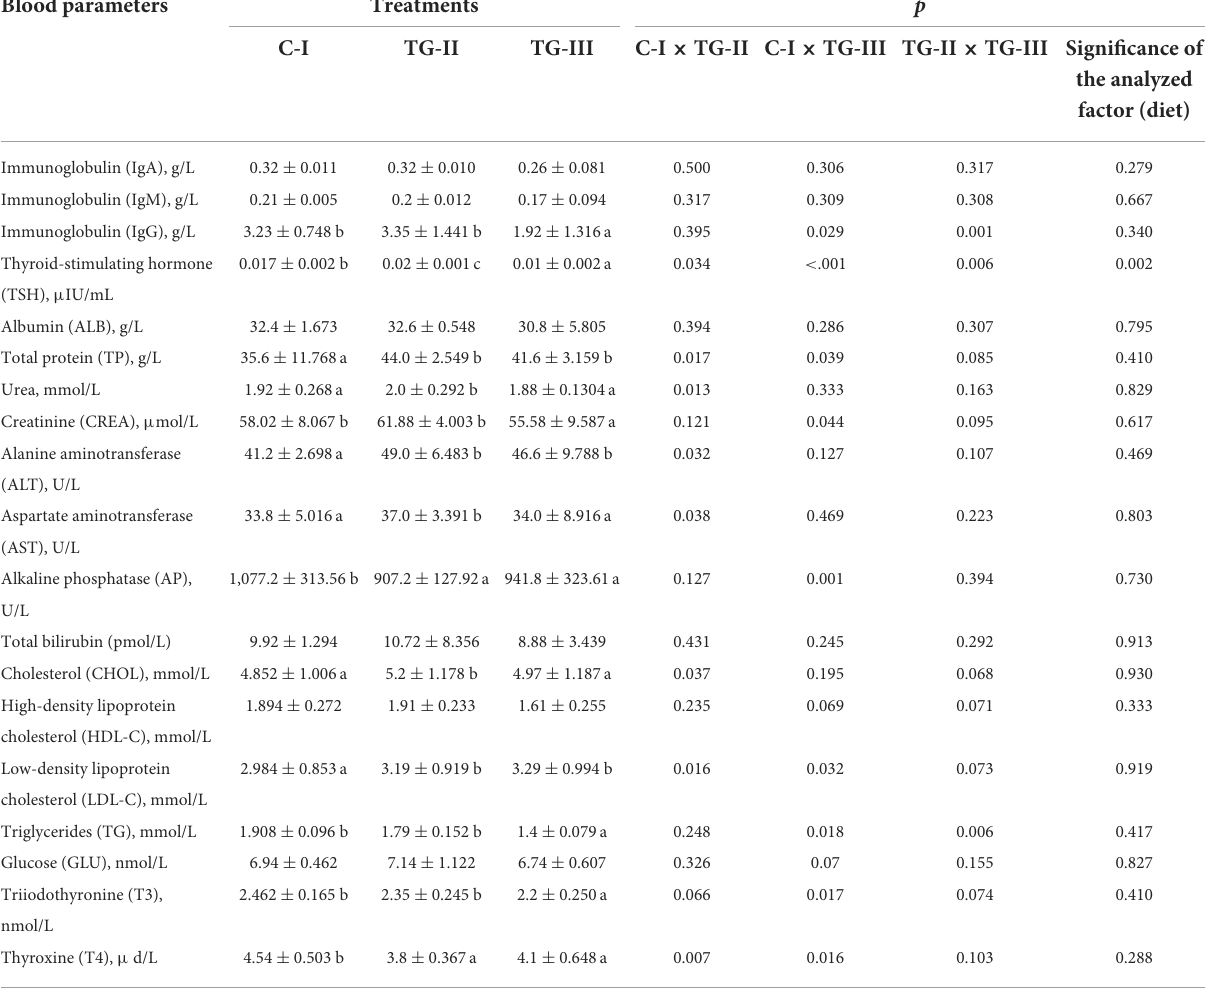
TABLE 2 Blood parameters of 18-day-old piglets. Blood